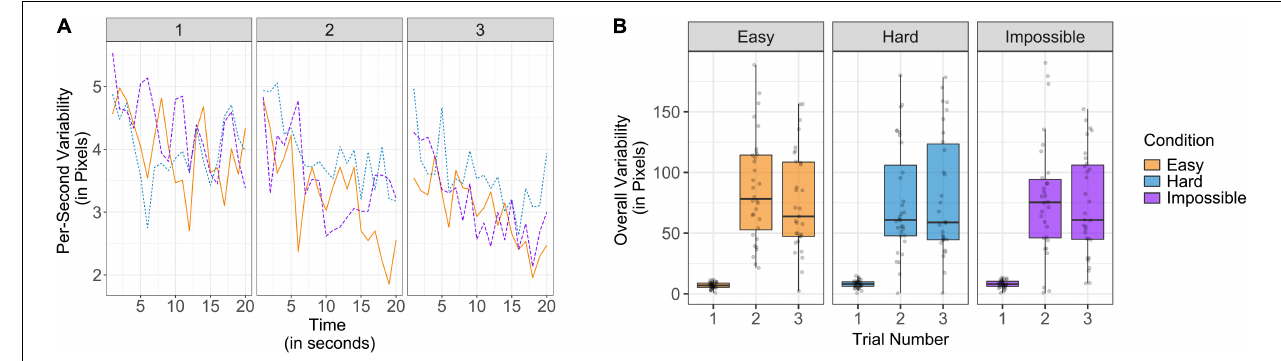
FIGURE 3 | Variability plotted (A) using a per-second score to represent variability in real-time and (B) using an overall score to represent the variability created across the entire trial, divided by condition and trial number. For each score, greater values represent greater variability and